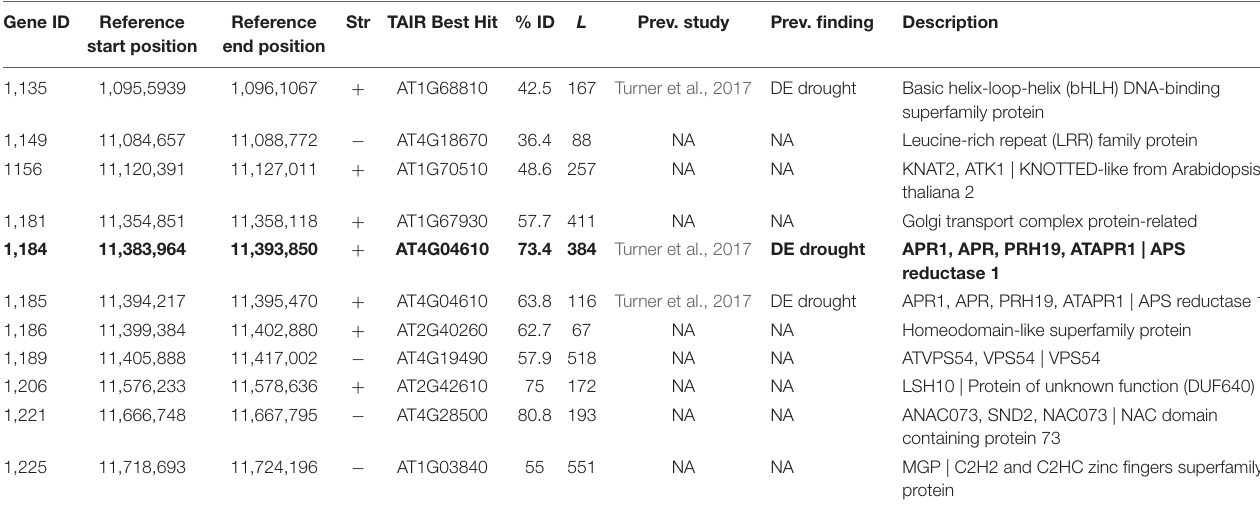
Selected genes (discussed in text) from annotated region of C. diffusa Chromosome TR001.Ccrd12 within 500 kb of significant GWAS hits (gene containing two significant SNPs in bold). For the full list of genes in this window (see Supplementary Table S4 ). “Str” indicates forward or reverse strand. “TAIR Best Hit” indicates best match to Arabidopsis thaliana annotation. “% ID” and “L” indicates percent identity with matching A. thaliana sequence and length of match. Included in this table are some genes investigated in previous studies of this species (“Prev. Study”). For the “Prev. Findings,” some genes were differentially expressed between control and drought treatments (“DE